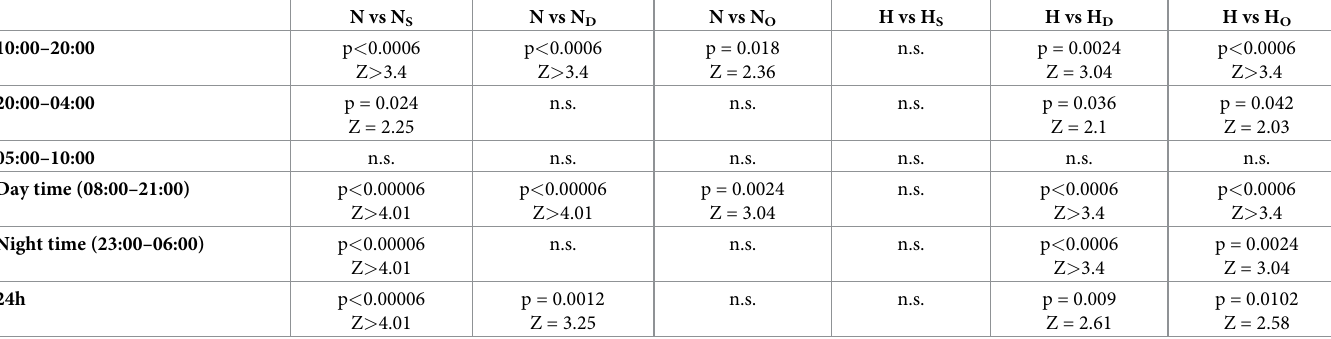
Table 5. P-value of the comparison between normotensive and hypertensive groups presenting the same risk factor. N vs H N S vs H S N D vs H D N O vs H O